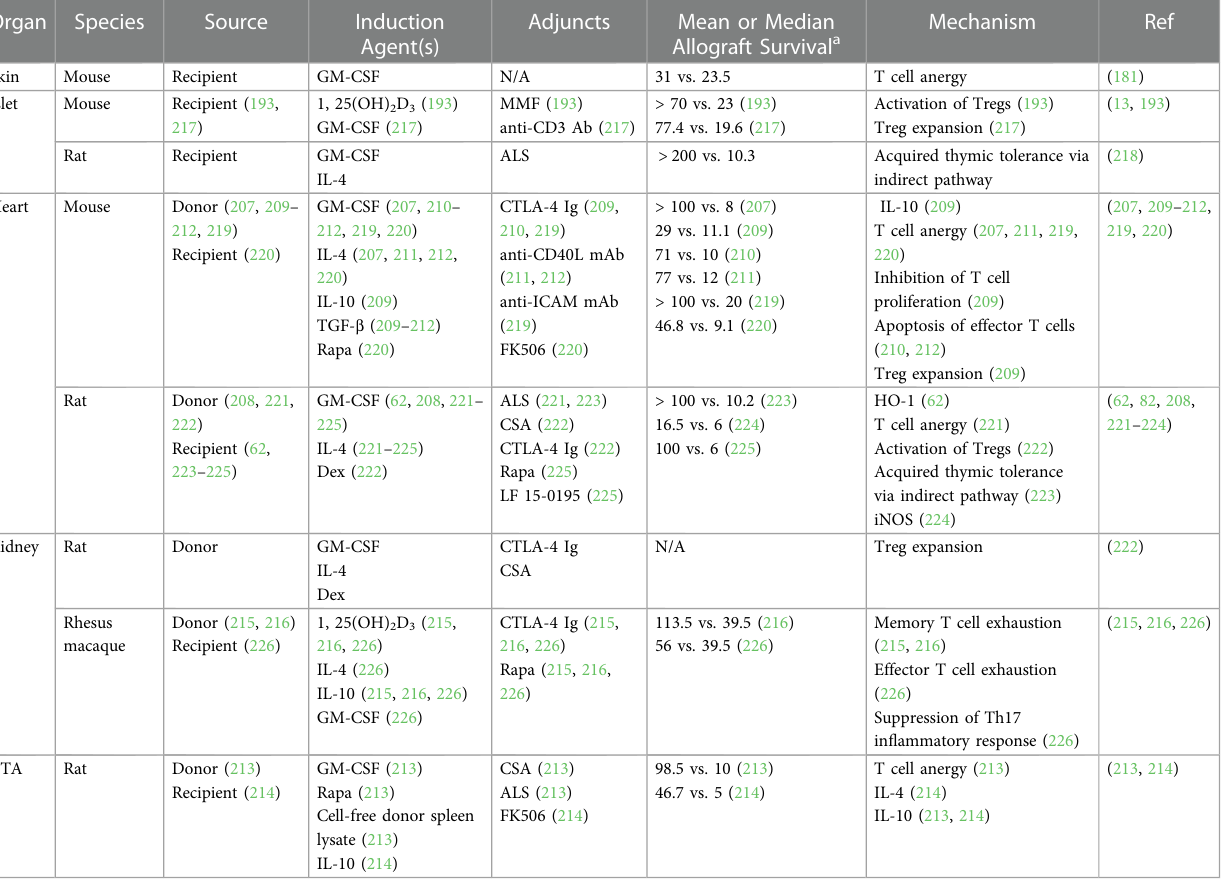
TABLE 2 Studies of regDCs in animal